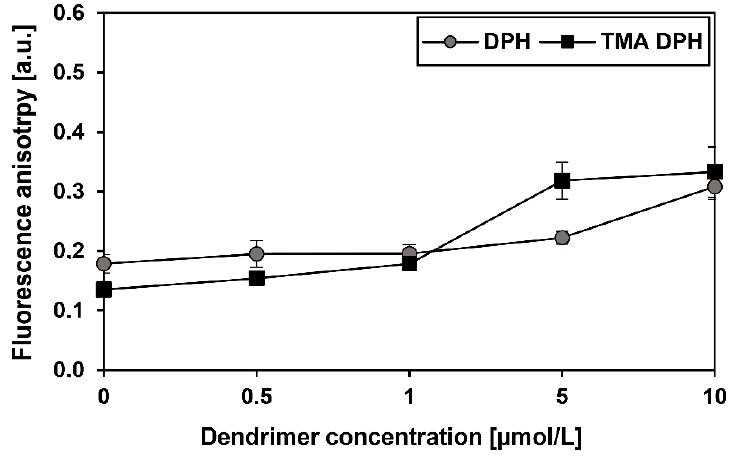
Figure 6. Changes in fluorescence anisotropy of DPH and TMA-DPH of erythrocyte membranes treated with ruthenium terminated carbosilane dendrimer with FITC (CRD13-FITC) at rising concentrations from 0.5 to 10 µmol/L, PBS buffer, pH 7.4, 37 °C. The values are the mean ± SD n = 3.